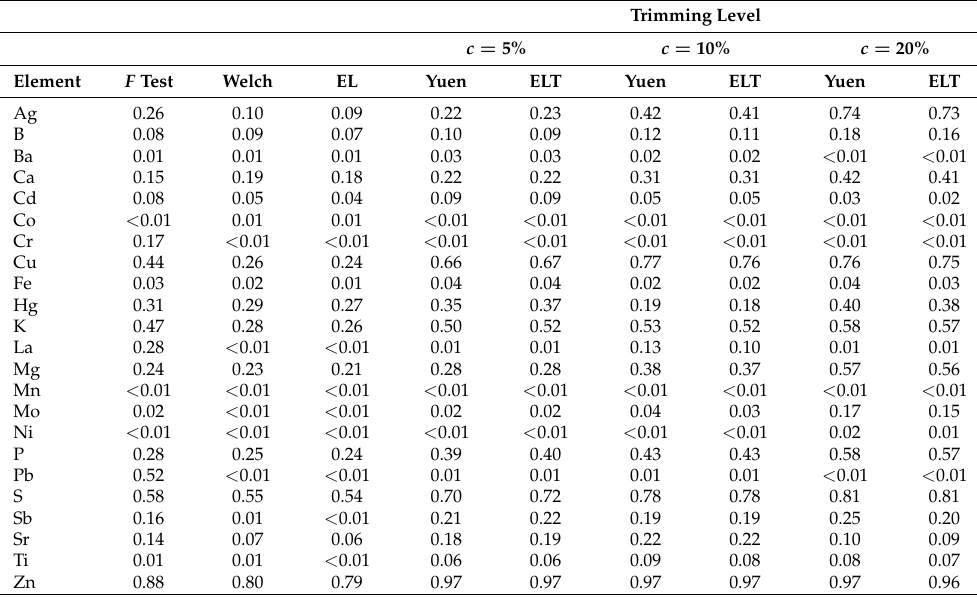
Table 4. p -values from tests of equality of means and trimmed means of 23 chemical element concentrations in plants collected along the Oslo Transect ([13]). Symmetric trimming, α i = β i = c , i = 1, . . . ,4. Trimming Level c = 5% c = 10% c = 20%